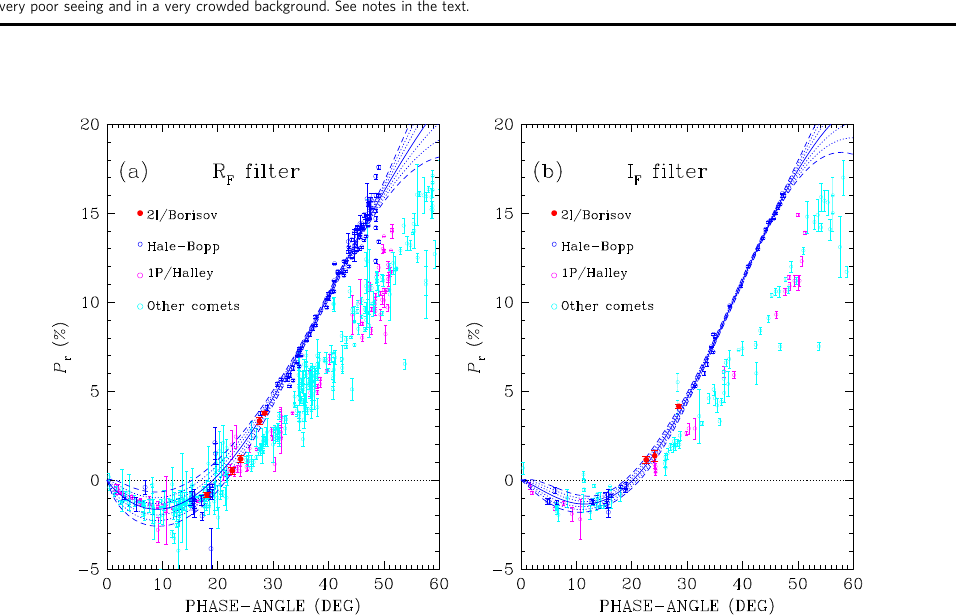
Fig. 1 Broadband polarimetry of 2I/Borisov and other comets. Panel a refers to the R F fi lter, and panel b to the I F fi lter. Red fi lled circles: data for 2I/Borisov. Empty blue, magenta and light blue circles: data for C/1995 O1 (Hale-Bopp) 11,38,73 – 76 , comet 1P/Halley 26 and other comets 26 , respectively. All data points are plotted with 1 σ error bars, calculated as explained in Methods subsection Polarimetry. The blue solid lines represent the best- fi t model to the Hale-Bopp data obtained with Eq. (1); dotted lines show the ±1 σ and ±2 σ uncertainties, dashed lines show its ±3 σ